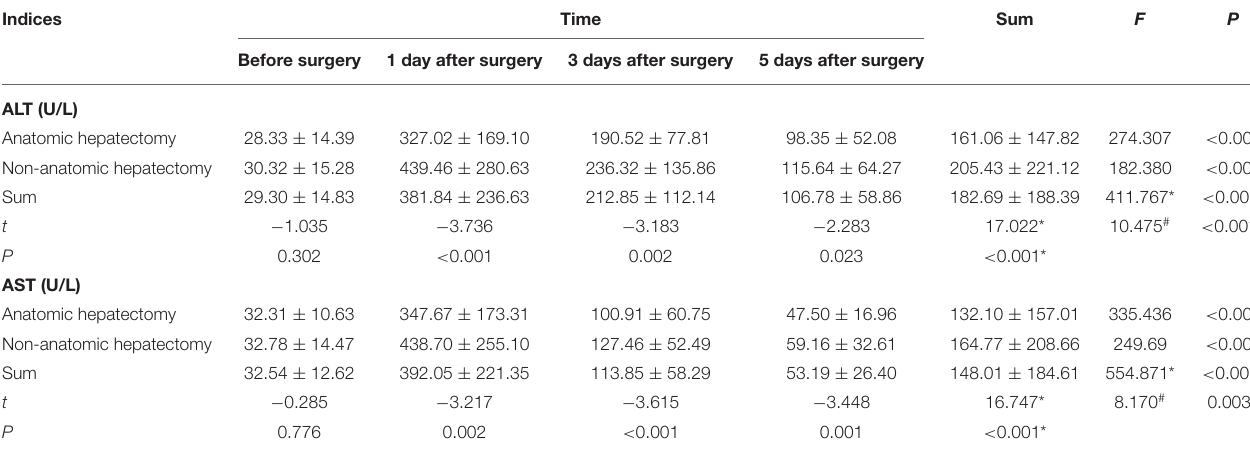
TABLE 3 | Comparison of liver function indices between the two groups at different times before and after surgery. Indices Time Sum F